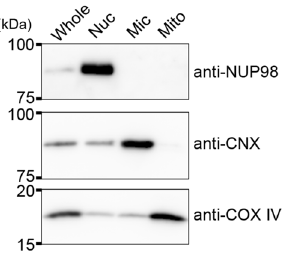
Figure 4. Isolation of organellar fractions from HepG2 cells. The whole-cell (Whole), purified nuclear (Nuc), microsomal (Mic) and mitochondrial (Mit) fractions (2.0 μg of protein) were separated by 7% or 15% SDS- PAGE and then immunoblotted with anti-NUP98, anti-CNX or anti-COX IV antibody. NUP98, CNX and COX IV are markers of the nucleus, ER and mitochondria, respectively. Three blots were cropped from different PVDF membranes. The full-length blots are presented in Supplementary Fig.